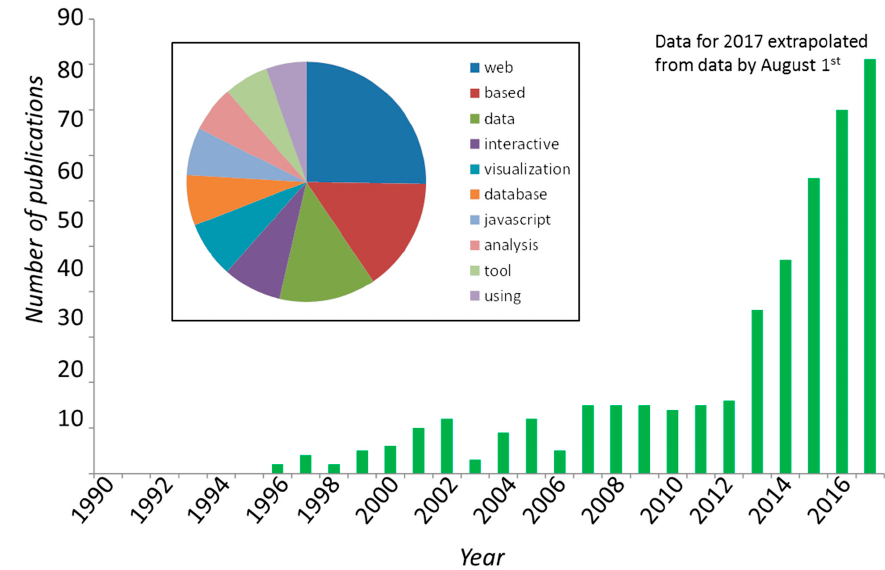
Figure 1. Tracking the use of JavaScript in science. Number of articles containing the word “JavaScript” in the title or abstract, yearly from 1990 to 2017. Inset: The 10 most frequent words in the titles of these articles. Data for 2017 was linearly extrapolated from counts by 1 August 2017. Table 1. Web apps and libraries of use in molecular biosciences, that rely entirely or largely on JavaScript, described in scientific literature. See text for details on many of these tools.